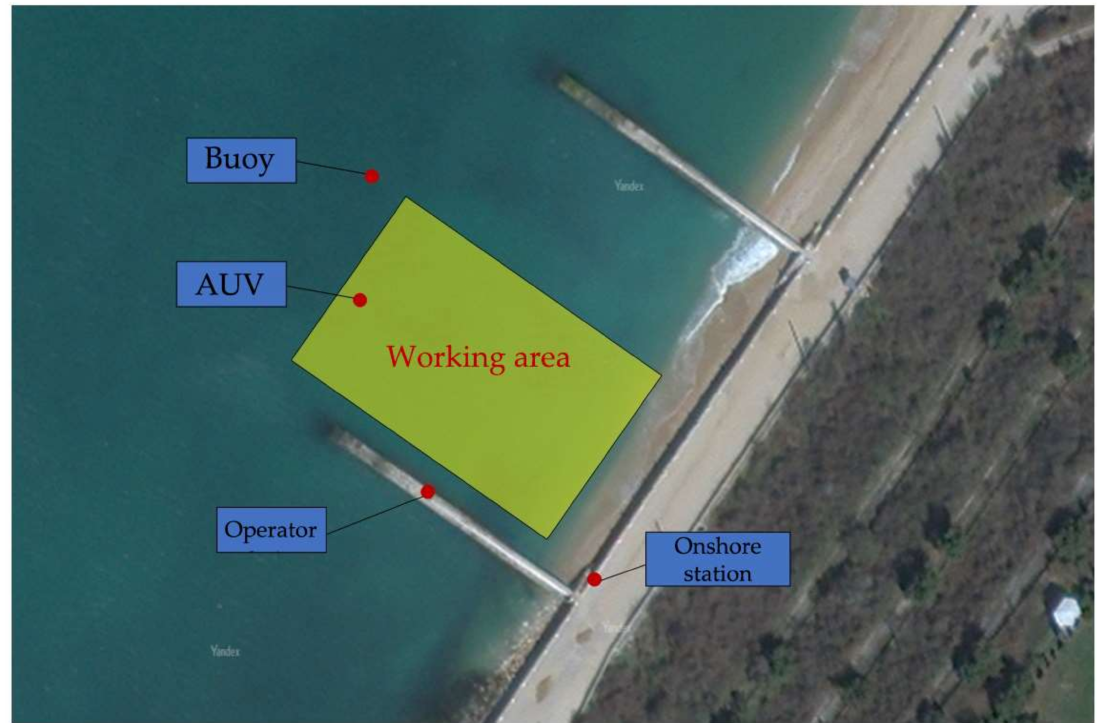
Figure 2. Equipment